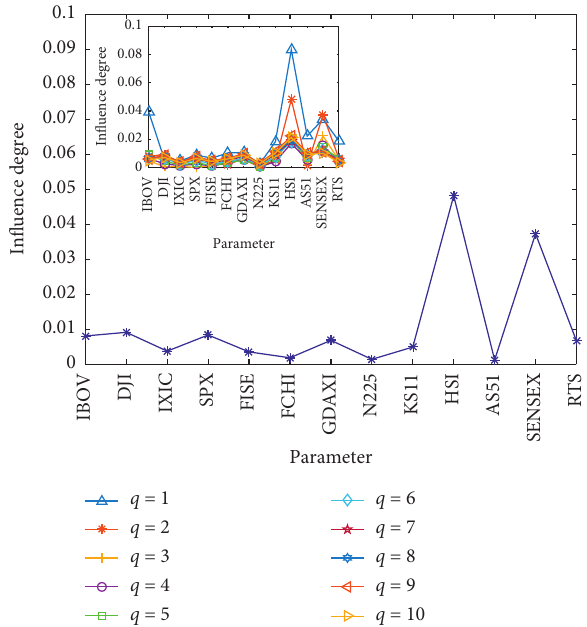
Figure 3: The influence degree of the first-order detrended partial cross-correlation in stock market and the influence degree of the first-order multifractal detrended partial cross-correlation coeffi- cient in stock market (inset).